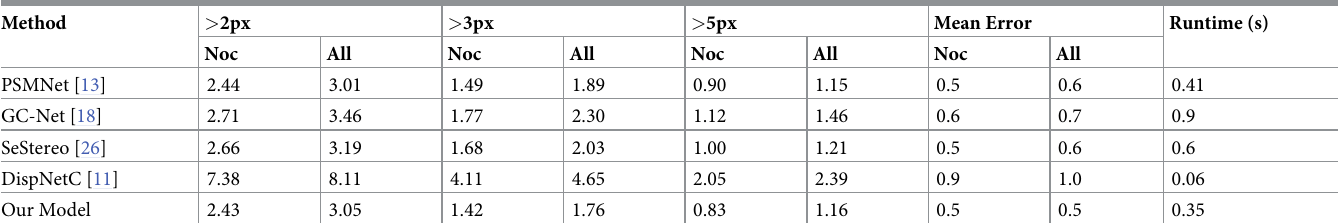
Table 5. KITTI 2012 quantitative assessment results.